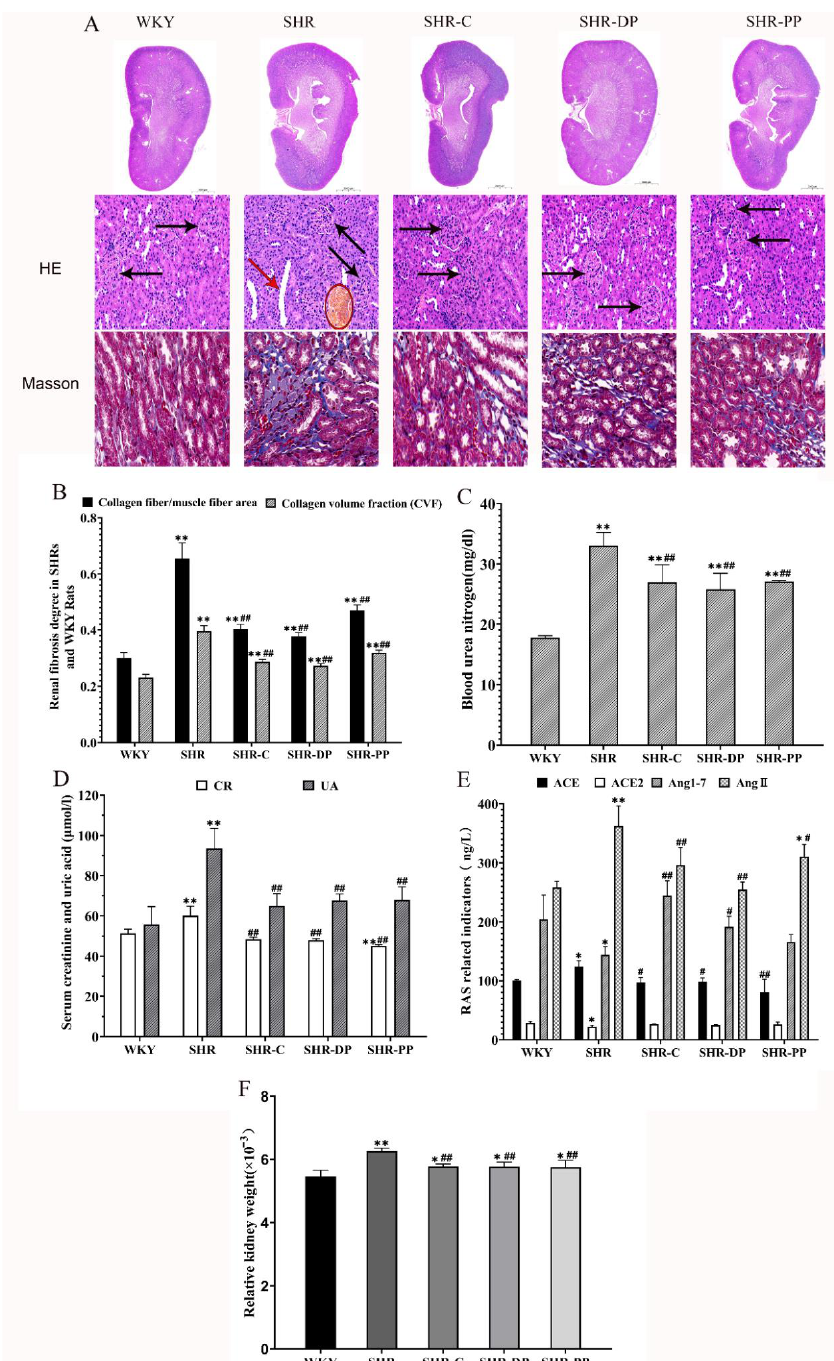
Figure 2. The influence of renal RAS system and renal function and the analysis of renal pathology of rats in each group after pea peptide and two-peptide composite intervention. ( A ) The represen- tative micrographs of rat renal tissues with the HE staining (0.7 × and 30 × ) and Masson staining (63 × ), glomerulus is represented by black arrow, renal tubule is represented by red arrow and renal interstitial congestion is represented by circle; ( B ) Degree of renal fibrosis in rats of each group; ( C , D ) Serum concentration of renal function-related markers (BUN, CR and UA); ( E ) Serum concen- tration of RAS system markers (ACE, ACE2, AngII, ANG(1-7)); ( F ) The relative organ weight of renal. The data in the figure are expressed as mean ± SEM. * p < 0.05, ** p < 0.01, represents the difference from the WKY group, respectively; # p < 0.05, ## p < 0.01, represents the difference from the SHR group,